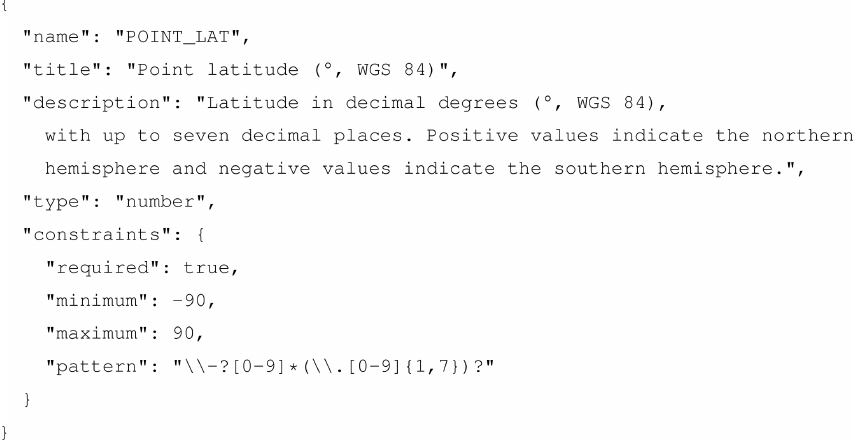
Figure 4. Sample JSON from datapackage.json specifying the name, title, description, data type, and value constraints for the field POINT_LAT in table TTT .